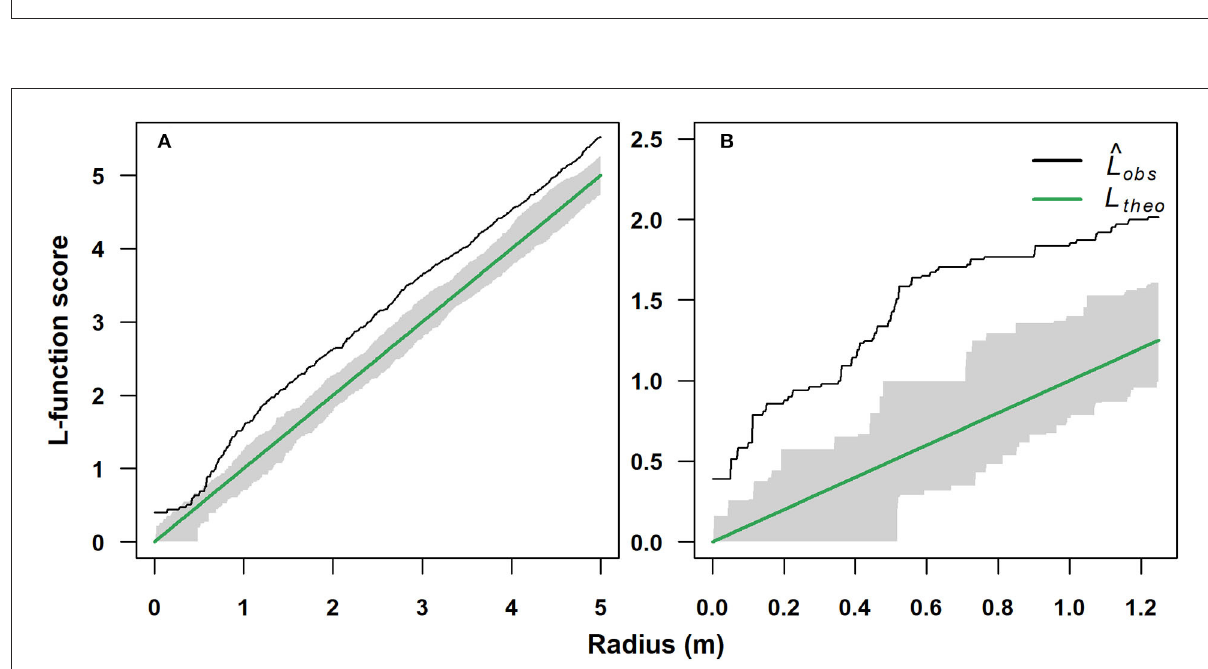
FIGURE3 Relationship between diameter at breast height and total tree height (A) , and variation of stem form index (B) of F. sylvatica from high elevation up to the species range elevation limit on the north-western slope of Serra del Prete. (A) Lines represent the regressed stand height semi-logarithmic model. The inset plot shows the estimated regression slope parameters of the non-linear regression model. Green and gray circles represent mean values and data observations, respectively. In the inset (see also Supplementary Table 1) and (B) , vertical bars indicate first standard deviation (SD).